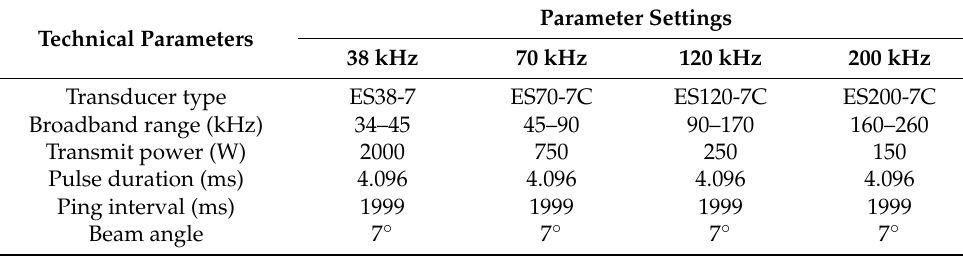
Table 1. Main parameter settings of Simrad EK80 echosounder